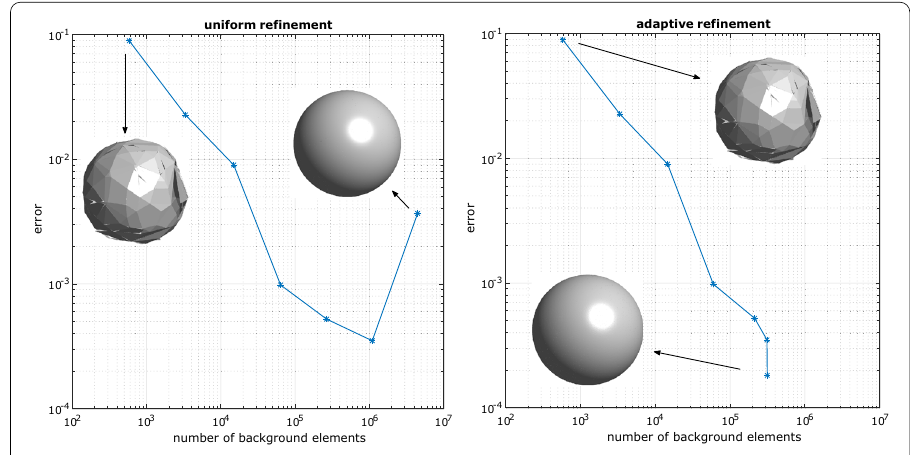
Fig. 27 Quantitative study of the approximation error for a sphere immersed into a continuously refined background mesh (The dots indicate six levels of refinement following two different